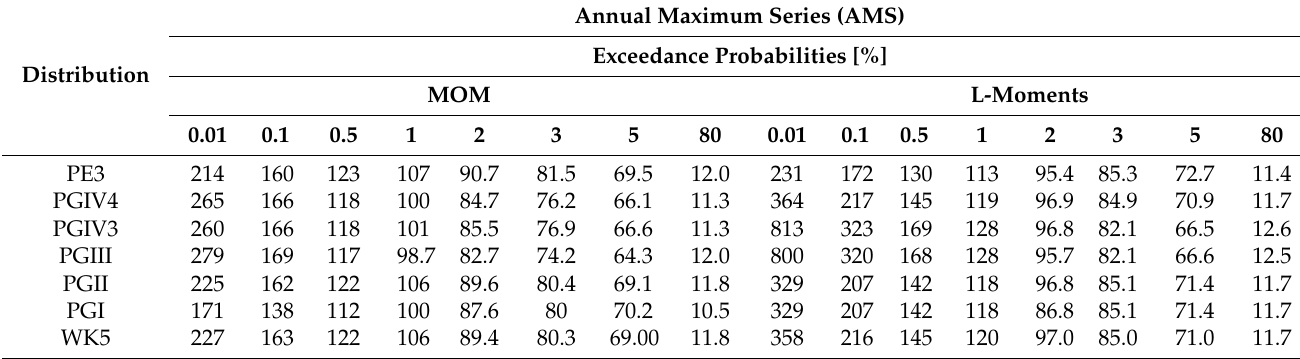
Table 7. Quantile results of the analyzed distributions for AMS.